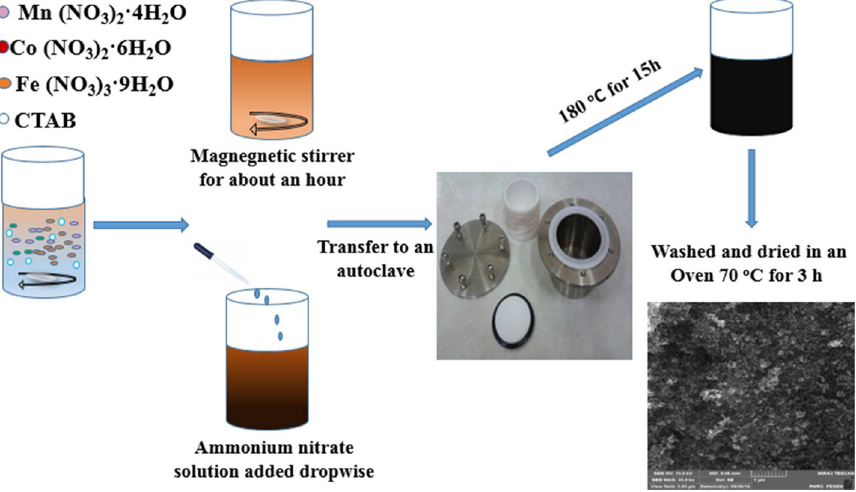
Figure 1. A schematic of the procedure followed to synthesize the manganese/nickel ferrite